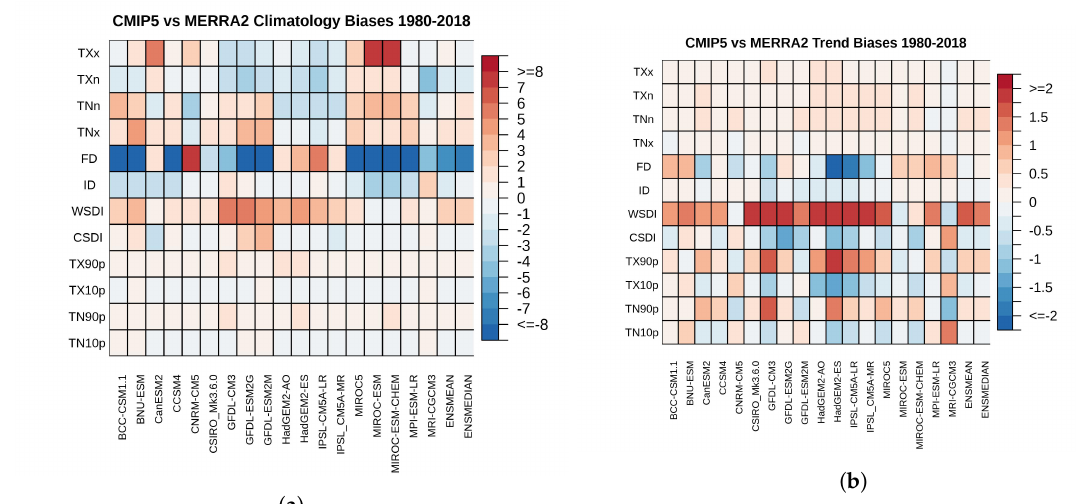
Figure A9. Portrait diagrams of domain-averaged biases of the 1980–2018 climatology ( a ) and the average decadal trend ( b ) of temperature indices simulated by the CMIP5 models with respect to MERRA-2 re-analyses. The biases are spatially averaged over MENA region land grid